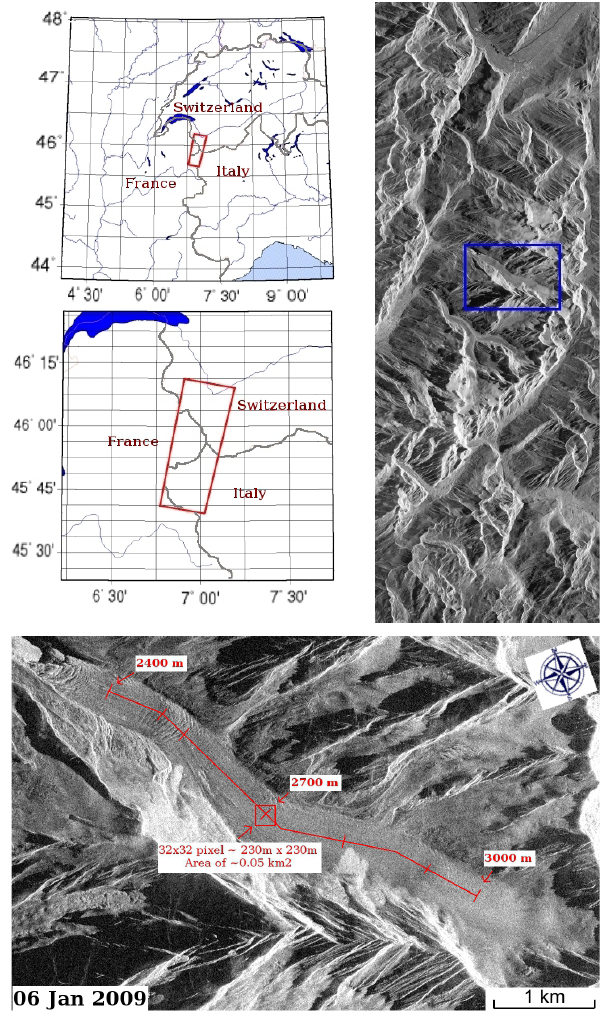
Figure 5. Top panels: location of the TerraSAR-X acquisition in the French Alps. Bottom panel: a cropped image on the Argentière glacier area. The approximate positions of different altitudes on the Argentière glacier: 2400, 2700 and 3000m on the TerraSAR-X im- ages are indicated. The red line represents the continuous trail on the glacier where the SAR data will be used in the case study; the marks on this line delineate each 100m of altitude.